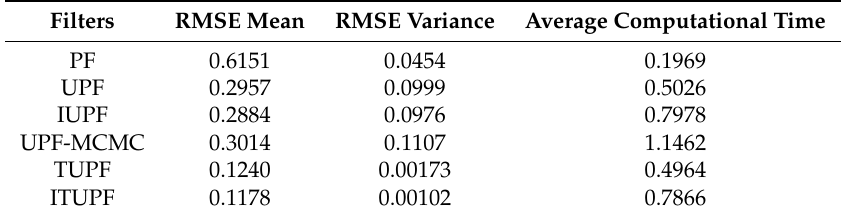
Table 2. RMSE and computational time of different particle